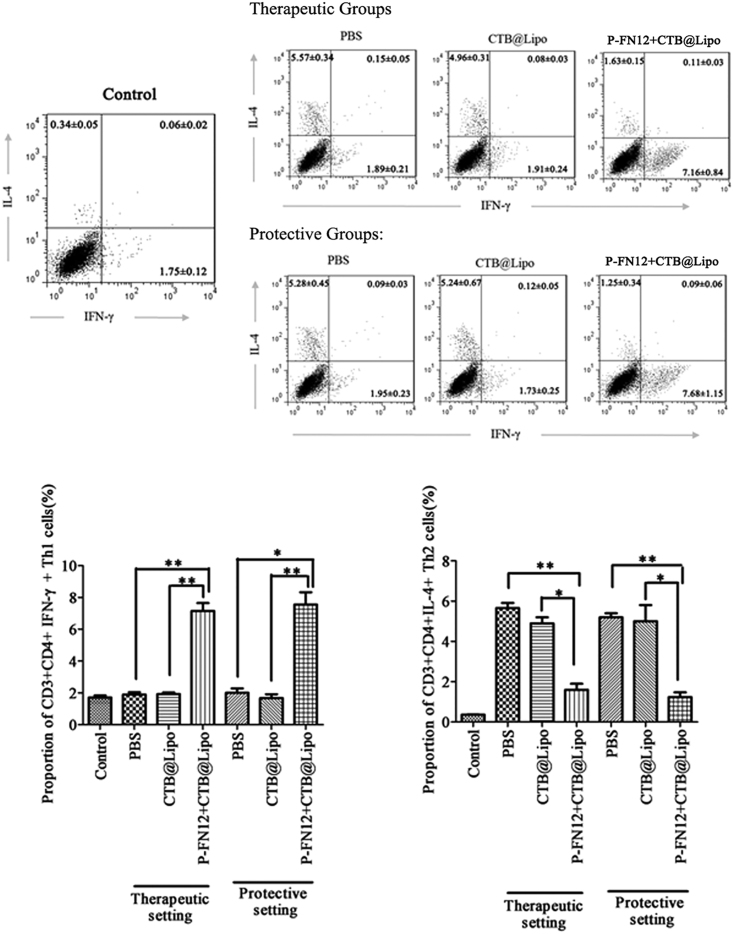
Th1/Th2 Cell Ratios among PBMCs of AR RatsThe proportions of CD3+CD4+ IFN-γ+ Th1 cells and CD3+CD4+IL-4+ Th2 cells among PBMCs were determined via flow cytometry (n = 5). PBMCs, peripheral blood mononuclear cells; control, no AR group; *p < 0.05, **p < 0.01.